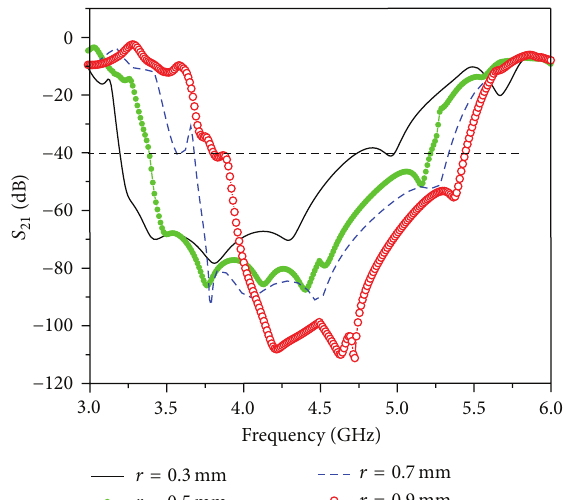
𝑔 . 21 as a function of